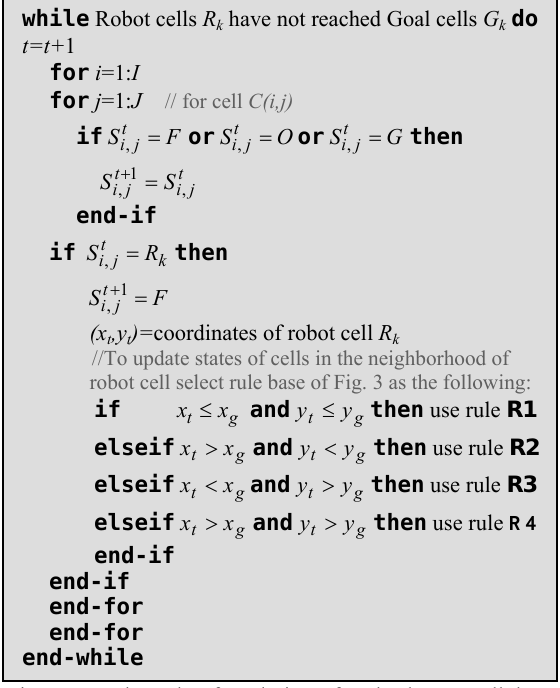
Fig. 5. Pseudo code of evolution of path planner cellular automata applicable for environments with convex